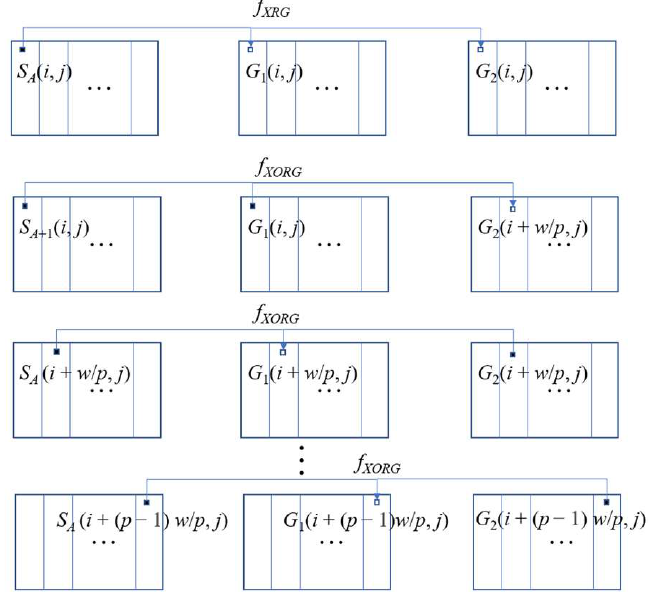
Figure 3. The schematic diagram of Algorithm 1 when A = 0. In Step 1 of Algorithm 1, we first select a random secret image S A from N secret images, and Step 2 select a fresh pixel G 1 ( i , j ). Step 3 generates two pixels by the Function f XRG . The first pixel G 1 ( i , j ) is at the same position as S A ( i , j ). The second pixel G 2 ( i + A × ( w/p ), j ) is shifted by A × ( w/p ) pixels for S A ( i , j ). The next encryption process will be divided into two parts, depending on whether the selected secret image S A is the last secret image or not. If S A is the last secret image ( S A = S N –1 ), the secret S A +1 encrypted with S A will be out of range, so we set it to be S 0 . In this case, the calculation will be different from the normal case. If the selected secret image S A is not the last one ( S A = { S 0 , S 1 , S 2 , . . . , S N –2 }), go to Step 4. The pixel G 2 (( i + A’ × w / p ) mod w , j ) is generated by the Function f XORG based on another secret image S A +1 of the same group with the share G 1 ( i , j ). Then, the pixel G 2 (( i